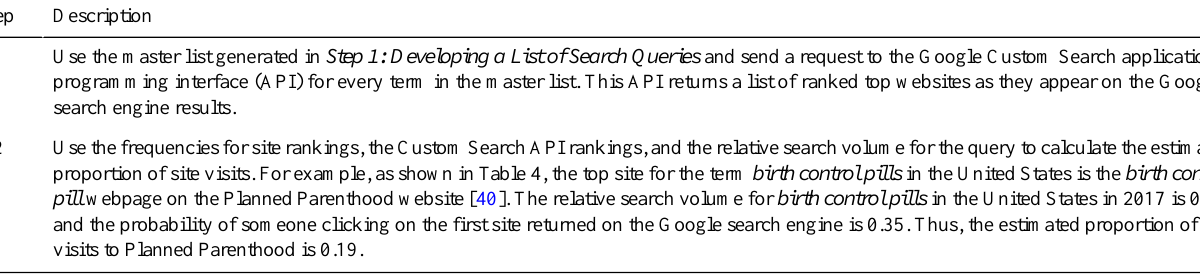
Table 3. Determining the most popular sites. DescriptionStep